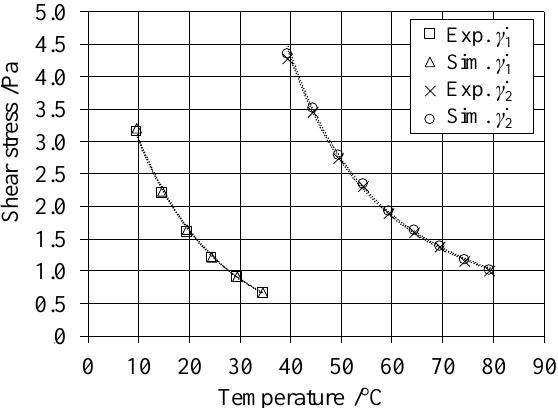
Fig. 7. Comparison of the numerically simulated oil shear stress τ O depending on the temperature t O with the experiment.